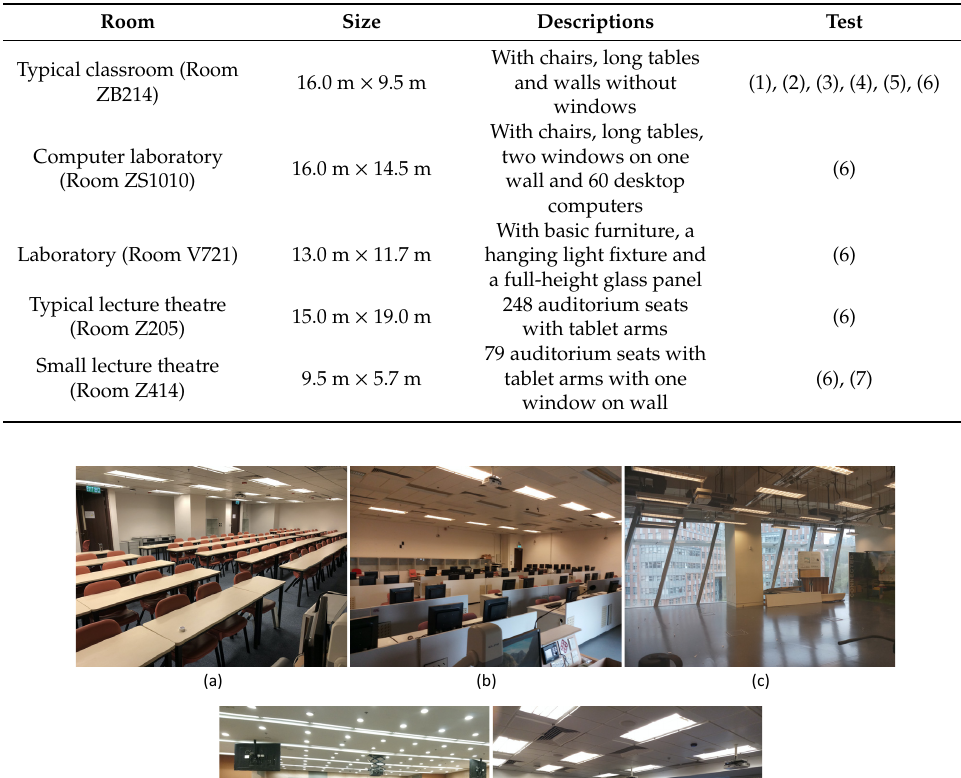
Table 2. Classroom used for performance testing.